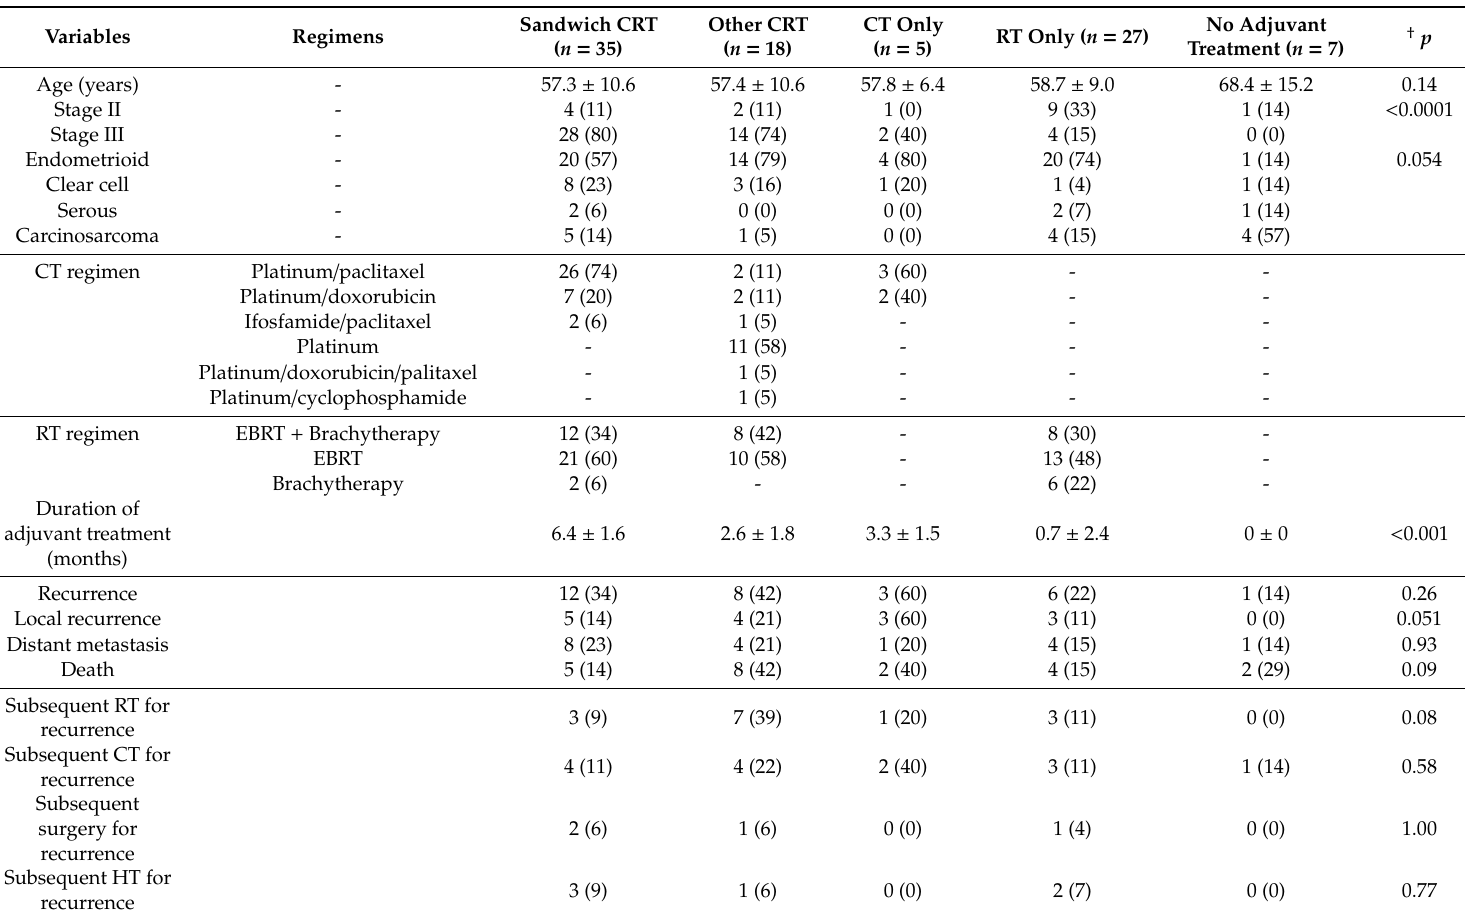
Table 2. Chemotherapy and radiotherapy regimens, and subsequent therapies for recurrence for women with high-risk endometrial cancer ( n = 92). Variables Regimens